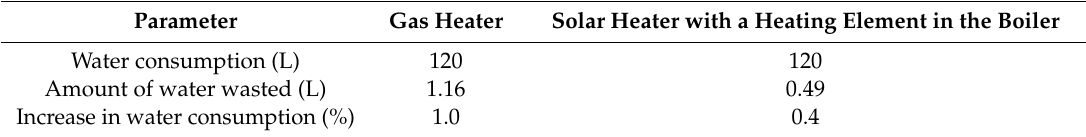
Table 9. Water consumption and water wasted per